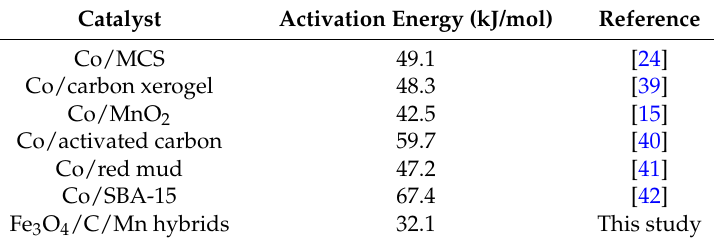
Figure 10. Phenol degradation on Mn/MCS ‐ R at different reaction temperature. Reaction conditions: [phenol] 0 = 20 mg/L, catalyst loading = 0.2 g/L, Oxone loading = 2.0 g/L. Table 2. Activation energies of representative Mn ‐ and Co ‐ based catalysts.